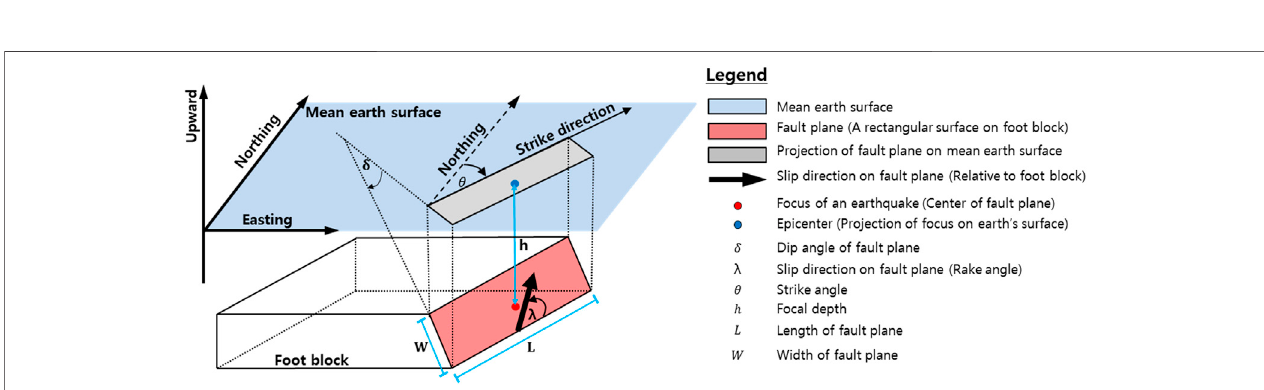
FIGURE 2 | Sketch of a fault plane and de fi nitions of fault parameters used in this study (from Wang, 2009).